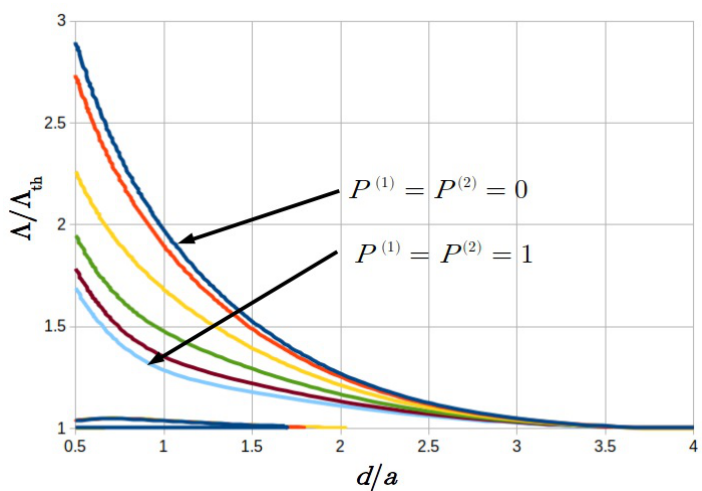
Figure 9. Stability boundaries for equal pump ellipticities. The calculated curves are for P ( 1 ) = P ( 2 ) ∈ { 0,0.2,0.4,0.6,0.8,1 } , with P ( 1 ) = 0 at the top and P ( 1 ) = 1 at the